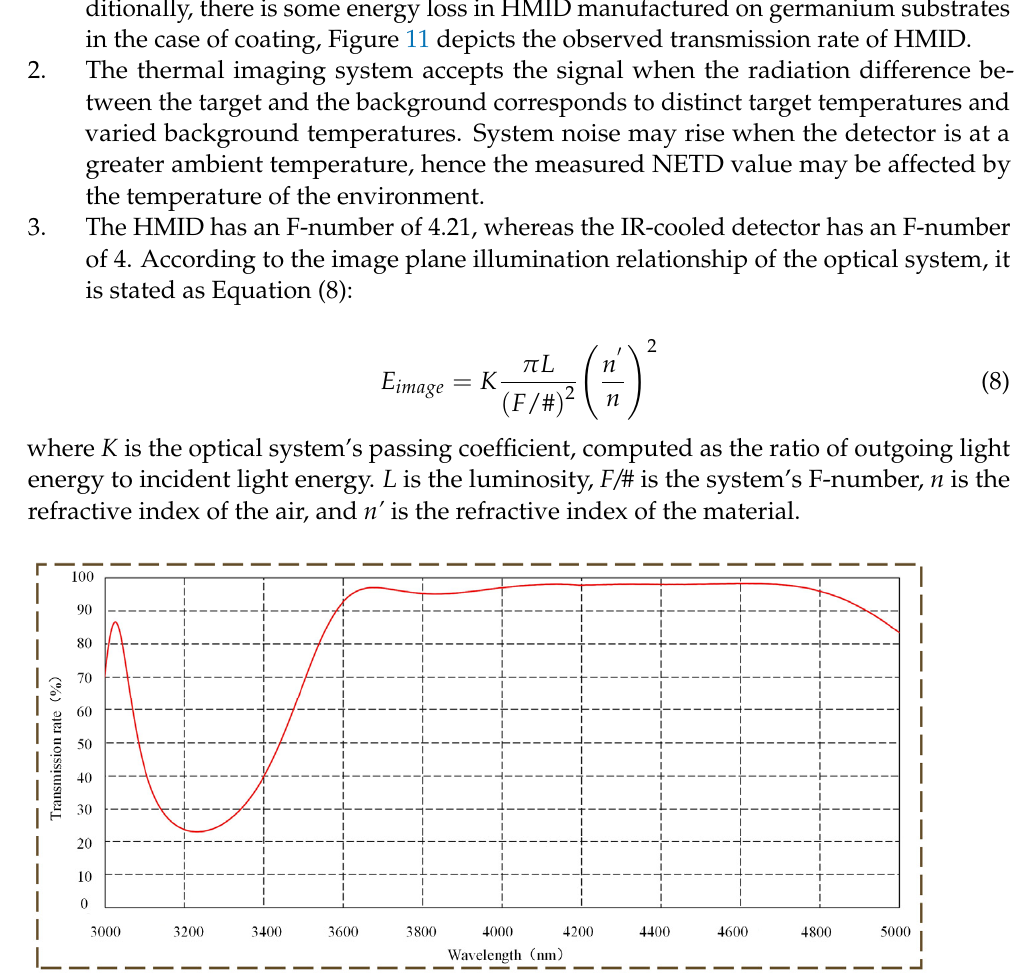
Figure 11. Measured transmittance of coated HMID.